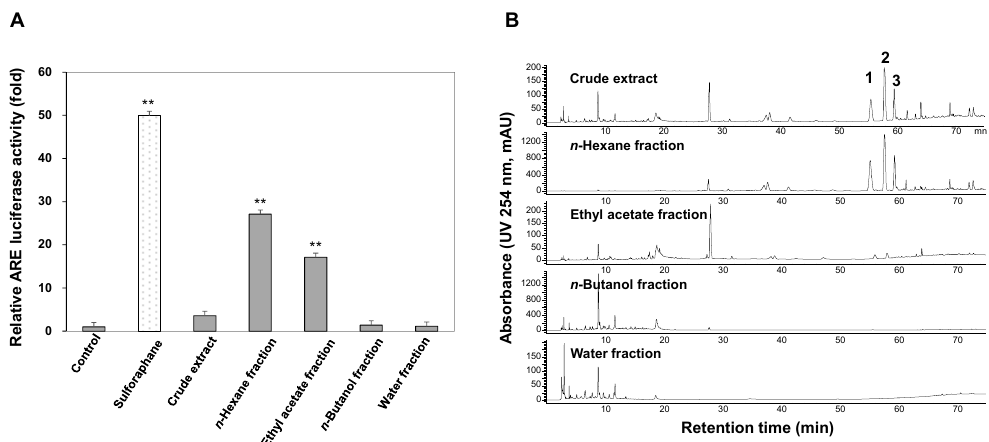
Figure 2. ARE luciferase activities in HepG2 cells ( A ) and HPLC chromatograms of the crude extract and its sub-fractions ( B ). The relative ARE luciferase activities were measured in the lysates of HepG2 cells that were stably transfected with pGL4.37 after exposure to 30 µg/mL of crude extract or sub-fractions for 12 h. Data are presented as means ± S.E. ( n = 5). ** p < 0.01 (compared with the vehicle-treated control).